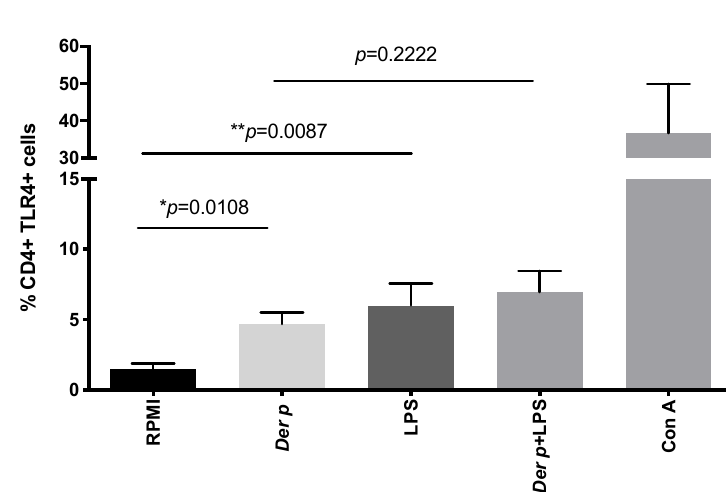
Figure 2. TLR4 expression in CD4 + T cells. After 72 h of culturing with Der p and LPS, we observed an increased percentage of CD4 + TLR4 + cells. * p ≤ 0.05; ** p ≤ 0.01.